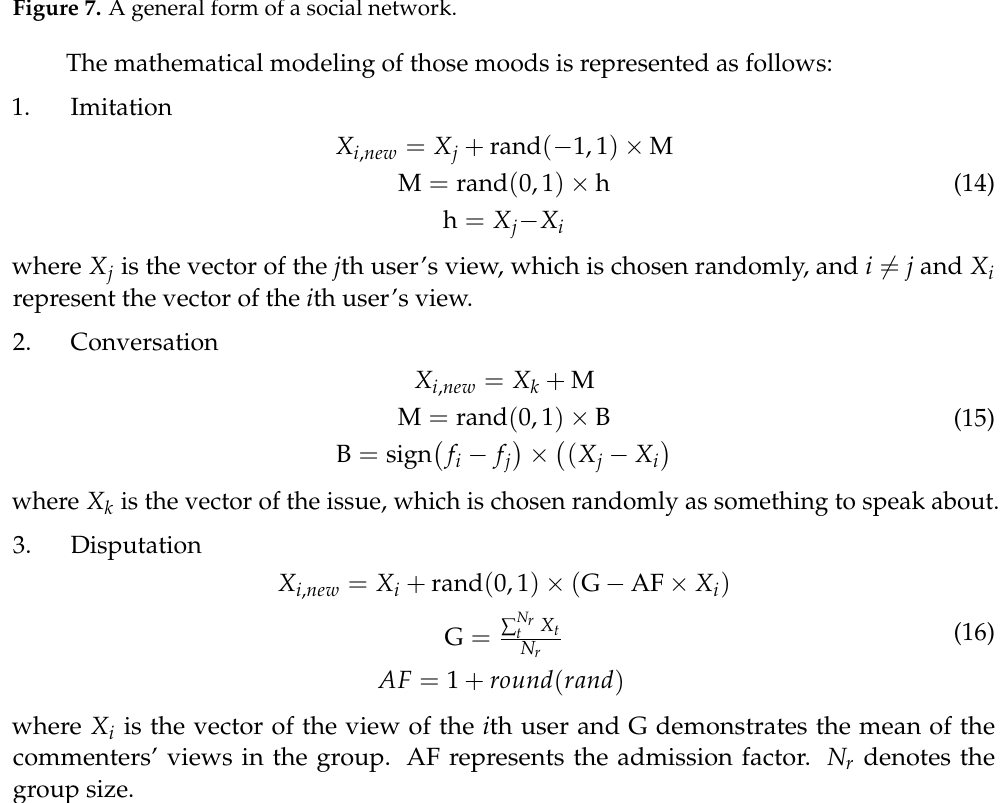
Figure 7. A general form of a social network.